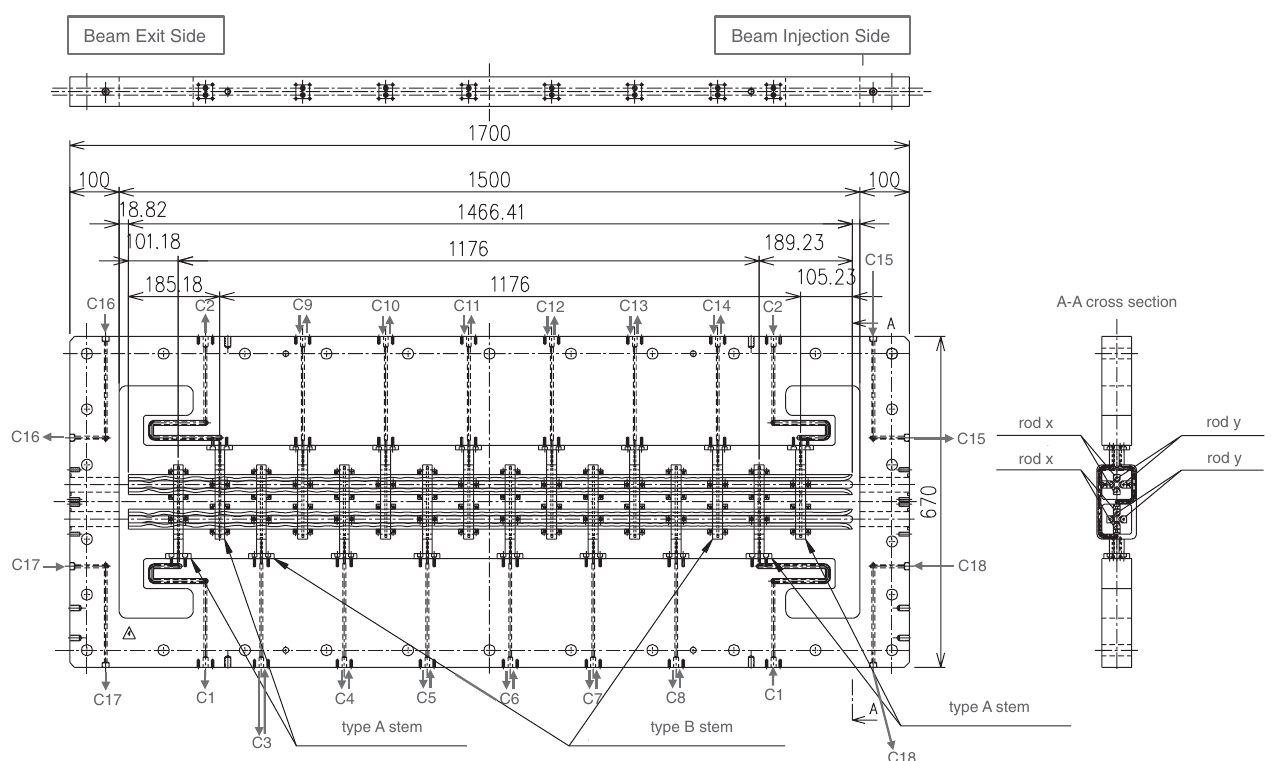
FIG. 7. Cooling structures in the heat-transfer and heat-stress simulations (dimensions are in mm). Dashed lines labeled C refer to circuits of cooling water.